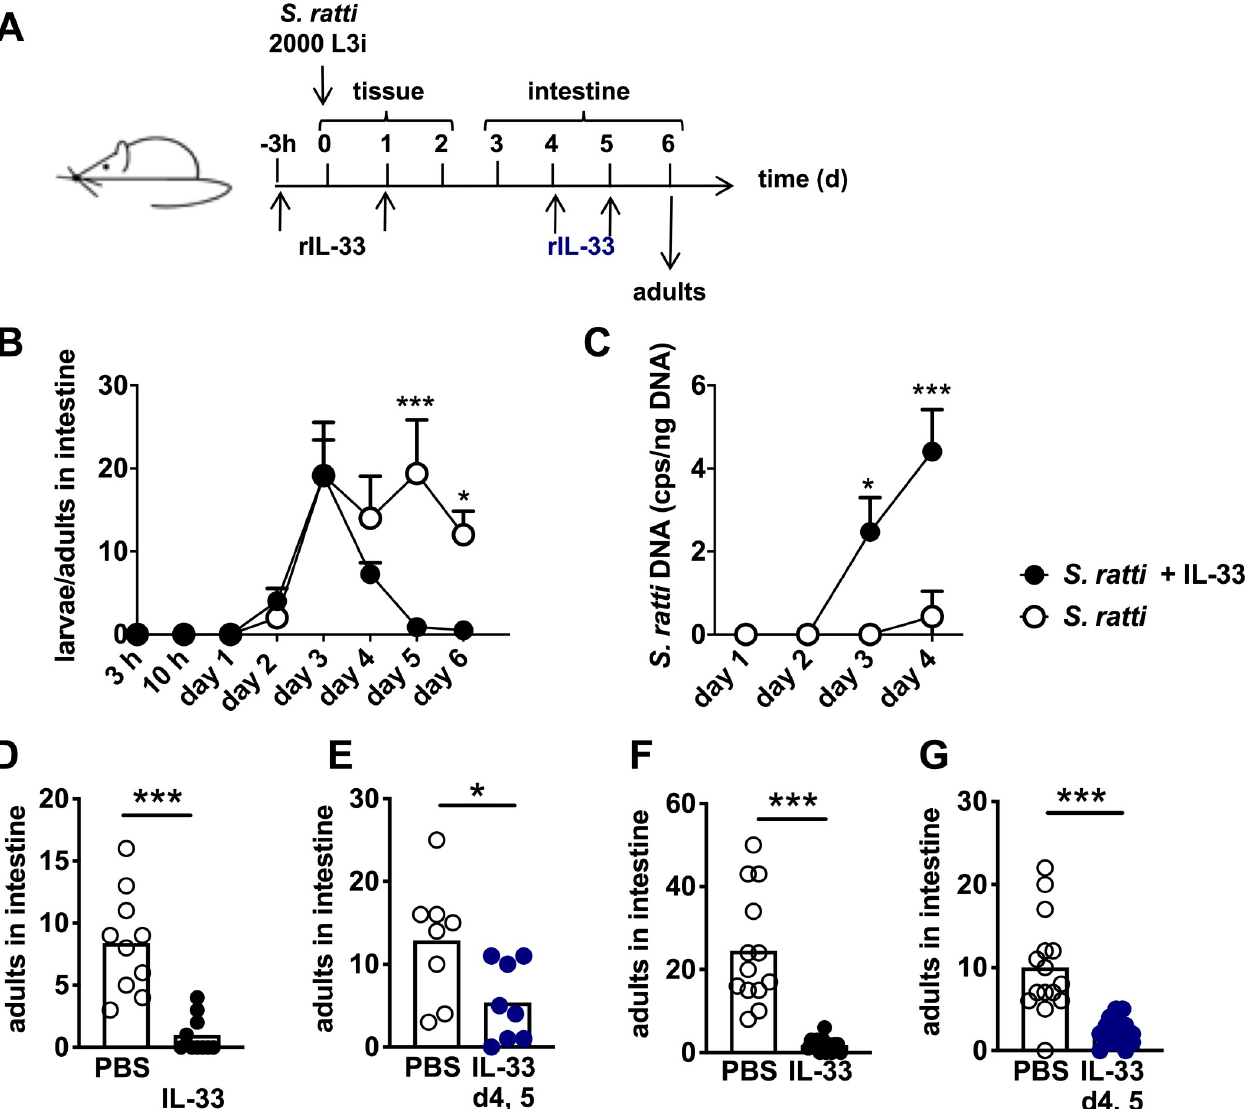
Fig 2. IL-33 reduces intestinal S . ratti burden independent of the tissue migration phase. (A) Experimental procedure: BALB/c mice were treated i.p. ( B,C, F, and G) or i.n. (D and E) with PBS (open circles) or 1 μ g rec. IL-33 (closed circles). Treatment was performed either 3 h before and 24 h after S . ratti infection ( black circles, B,C,D, and F) or after the tissue migration phase i.e. 4 days and 5 days after S . ratti infection ( blue circles, E and G) . (B) Mice were sacrificed at the indicated time points and L3, L4 and adults in the intestine were counted and (C) S . ratti -derived DNA in the feces was quantified by qPCR at the indicated time points. Shown are the combined results of 2 independent experiments (n = 4 per experiment, group, and time point), symbols show the mean and error bars indicate SEM (D-G) . Adults in the intestine were counted at day 6 p.i. Shown are combined results from 2–3 independent experiments (n = 3–5 each), each symbol represents an individual mouse, bars show the mean and asterisks indicate statistically significant difference of the means ( B and C : two-way ANOVA, D-G: students t-test). https://doi.org/10.1371/journal.ppat.1009121.g002 (Fig 2F) and also i.p. application of IL-33 after completion of the tissue migration phase at day 4 and 5 p.i., reduced the intestinal parasite burdens on the next day (Fig 2G). Taken together these results show that endogenous IL-33 which is naturally produced and/ or released during S . ratti infection promoted eradication of parasites from the intestine as blockade of endogenous IL-33 increased and stabilization of endogenous IL-33 decreased par- asite burden. Exogenous application of rec. IL-33 phenocopied stabilisation of endogenous IL-